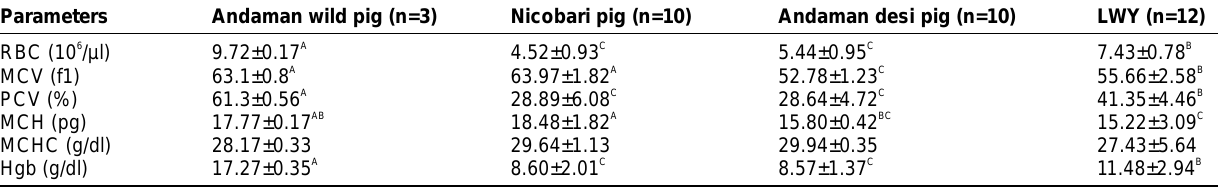
Table-1. Comparative Erythrocytic parameters of different pig breeds of Andaman and Nicobar Islands